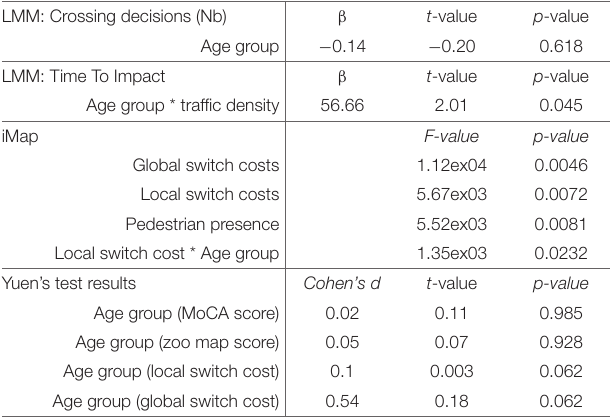
TABLE 1 | Summary of the main findings mentioned in the Results (3).